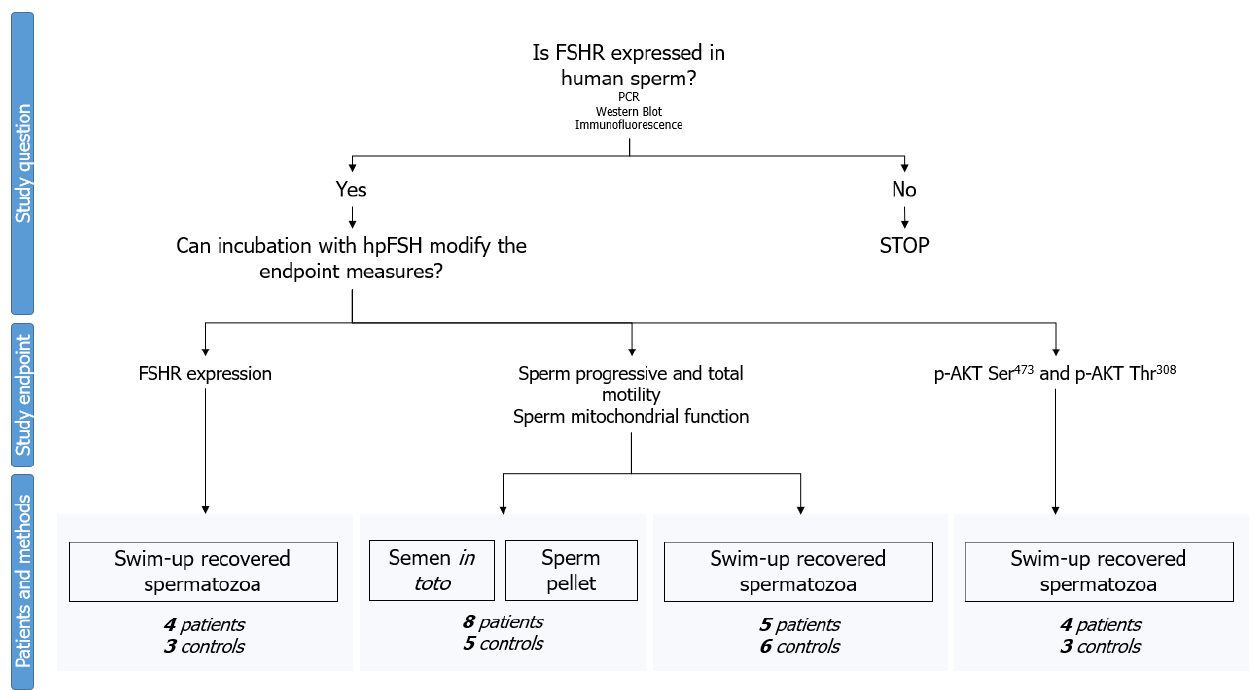
Figure 6. Flow chart of the experimental design. After confirmation of follicle-stimulating hormone receptor (FSHR) expression in human spermatozoa by polymerase chain reaction (PCR), Western blot, and immunofluorescence, experiments were conducted in men with normozoospermia and patients with asthenozoospermia using spermatozoa separated by swim-up, in-toto semen, or semen pellets.